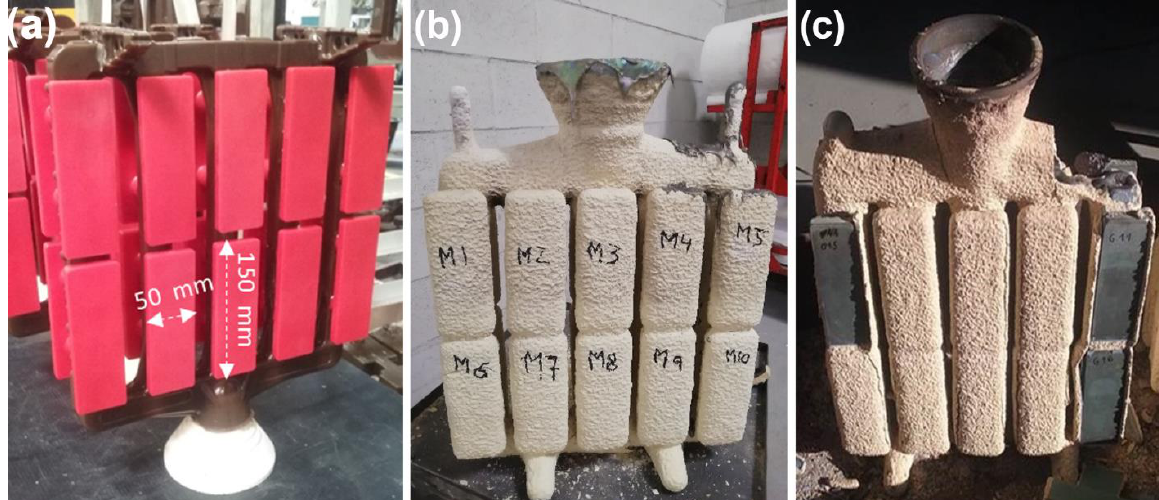
Table 2. Chemical composition measured in the raw materials and in the manufactured samples.